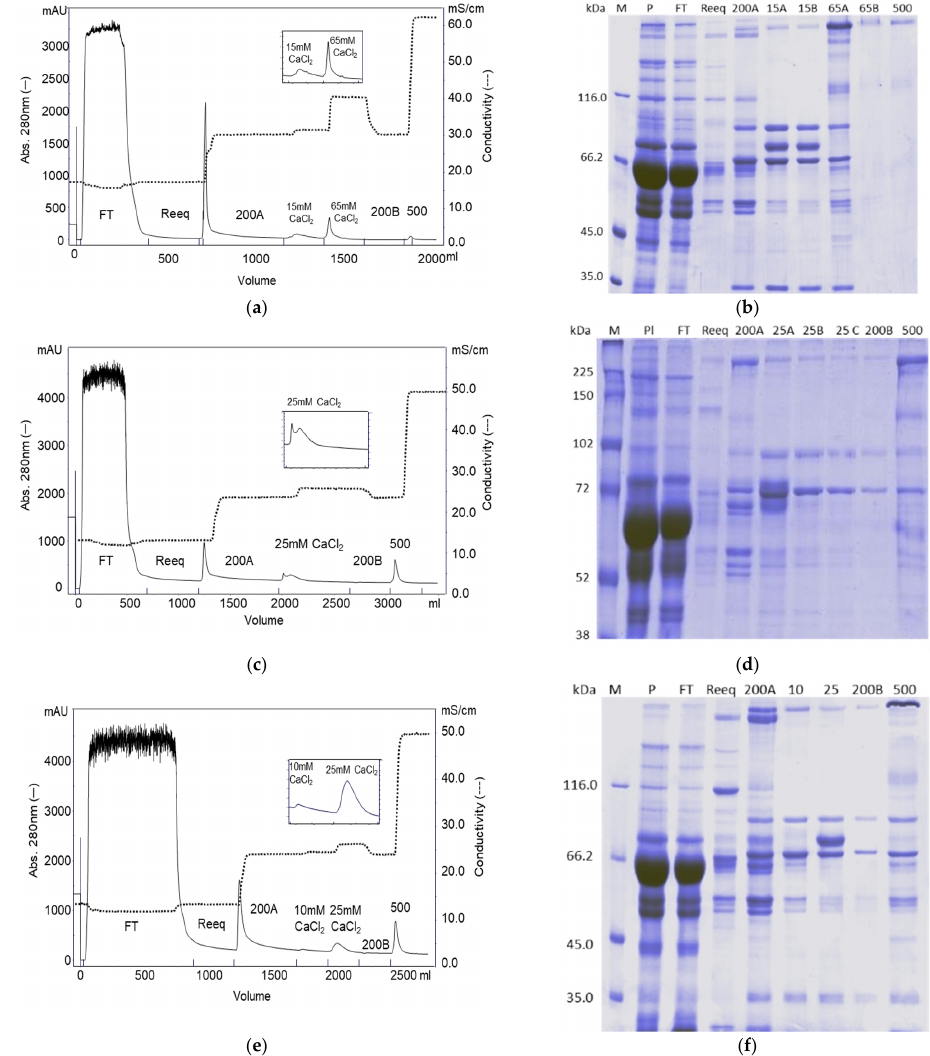
Figure 4. ( a ) Chromatogram of purification of plasma on Q Sepharose FF with stepwise 15 and 65 mM CaCl 2 gradient; ( b ) SDS-PAGE 7.5% analysis under reducing conditions of purification of plasma on Q Sepharose FF with stepwise 15 and 65 mM CaCl 2 gradient. Lanes: M- molecular mass marker; P- plasma; FT- flow through; Reeq- reequilibrium fraction; 200A- first wash with Buffer B;15A and 15B- first and second fractions eluted with 15 mM CaCl 2 in 25 mM citrate, 200 mM NaCl, pH 6.0 buffer; 65A and 65B- fractions eluted with 65 m CaCl 2 in 25 mM citrate, 200 mM NaCl, pH 6.0 buffer; 200B- second wash with buffer B; and 500- fraction eluted with Buffer C; ( c ) Chromatogram of purification of plasma on ANX Sepharose FF with stepwise 25 mM CaCl 2 gradient; ( d ) SDS- PAGE 7.5% analysis under reducing conditions of purification of plasma on ANX Sepharose FF with stepwise 25 mM CaCl 2 . Lanes: M: molecular mass marker; P: plasma; FT: flowthrough; Reeq- reequilibrium fraction; 200A: first wash with Buffer B; 25A, 25B and 25C: first, second and third fractions eluted with 25; mM, CaCl 2 in 25 mM citrate, 200 mM NaCl, pH 6.0 buffer; 200B: second wash with buffer B; and 500- fraction eluted with Buffer C; ( e ) Chromatogram of purification of plasma on ANX Sepharose FF with stepwise 10 mM and 25 mM CaCl 2 gradient; and ( f ) SDS-PAGE 7.5% analysis under reducing conditions of purification of plasma on ANX Sepharose FF with stepwise 10 mM and 25 mM CaCl 2 gradient. Lanes: Lanes: M: molecular mass marker; P: plasma; FT: flowthrough; Reeq: reequilibrium fraction; 200A: first wash with Buffer B; 10: fractions eluted with 10 mM CaCl 2 in 25 mM citrate, 200 mM NaCl, pH 6.0 buffer; 25: fractions eluted with 25 mM CaCl 2 in 25 mM Citrate, 200 mM NaCl, pH 6.0 buffer; 200 B: second wash with Buffer B; and 500: fraction eluted with Buffer